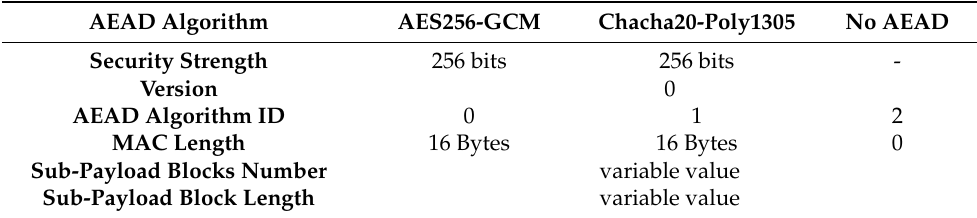
Table 2. AEAD algorithms and values of the corresponding